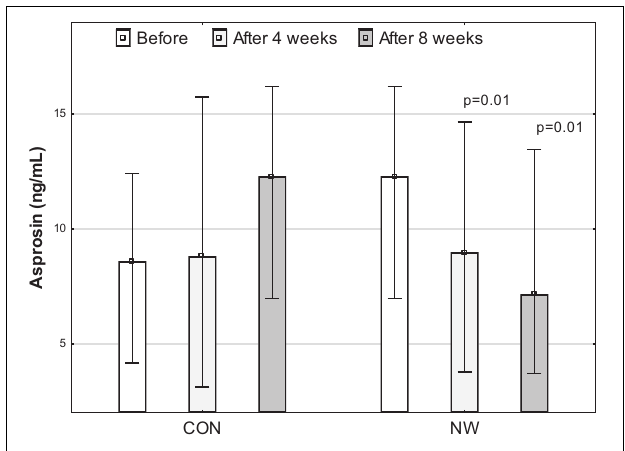
FIGURE 1 | Asprosin concentration in blood plasma during the control (CON) tests and the Nordic walking stage (NW). Data are presented as medians (Me) and quartiles (Q1, Q3); p < 0.05 – statistically significant difference with regard to baseline value at a given